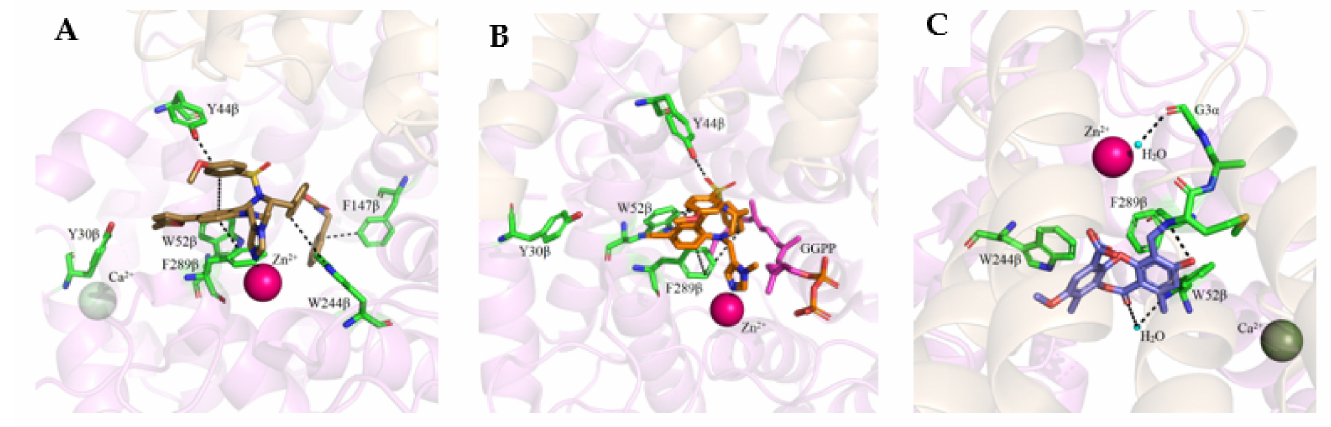
Figure 11. Structure of Rab GGTase with BMS3 ( A ) (PDB: 3PZ3), FTase with BMS3 ( B ) (PDB: 3PZ2), and Rab GGTase in complex with covalently bound psoromic acid ( C ) (PDB: 4EHM). (Created in the PyMOL Molecular Graphics System, Version 2.5.2 Schrödinger,